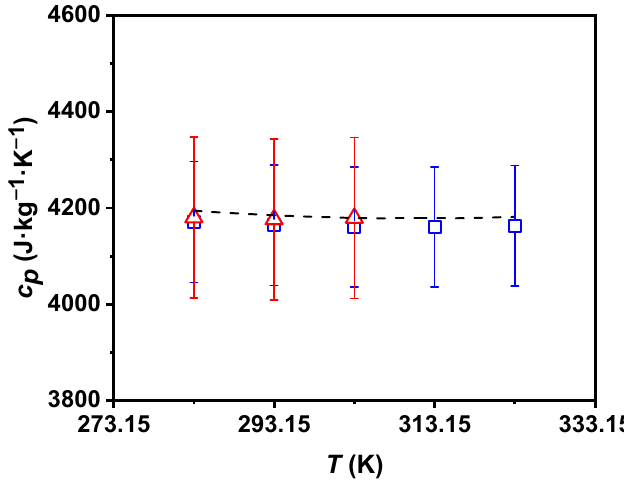
Figure 4. Experimental isobaric specific heat capacity, c p , of 0.50 wt% P-GnP/W nanofluid (UVigo laboratory, ☐ ; ILK laboratory, △ ) and literature c p of water (- - -) [55] as a function of temperature, T . Error bars indicate expanded uncertainty ( k = 2).